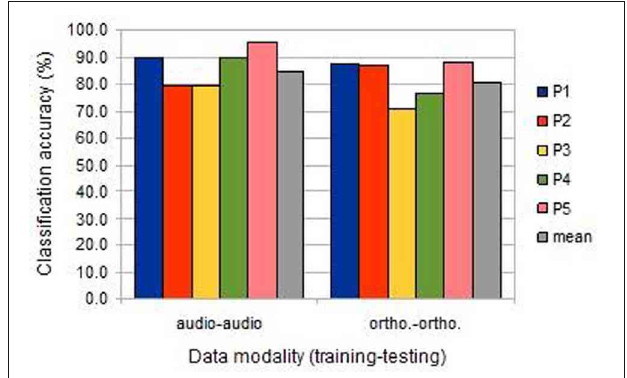
FIGURE 3 | The classification accuracies obtained under the inter-session cross-modal conditions from the five participants (BOLD delay = 4; number of volumes =